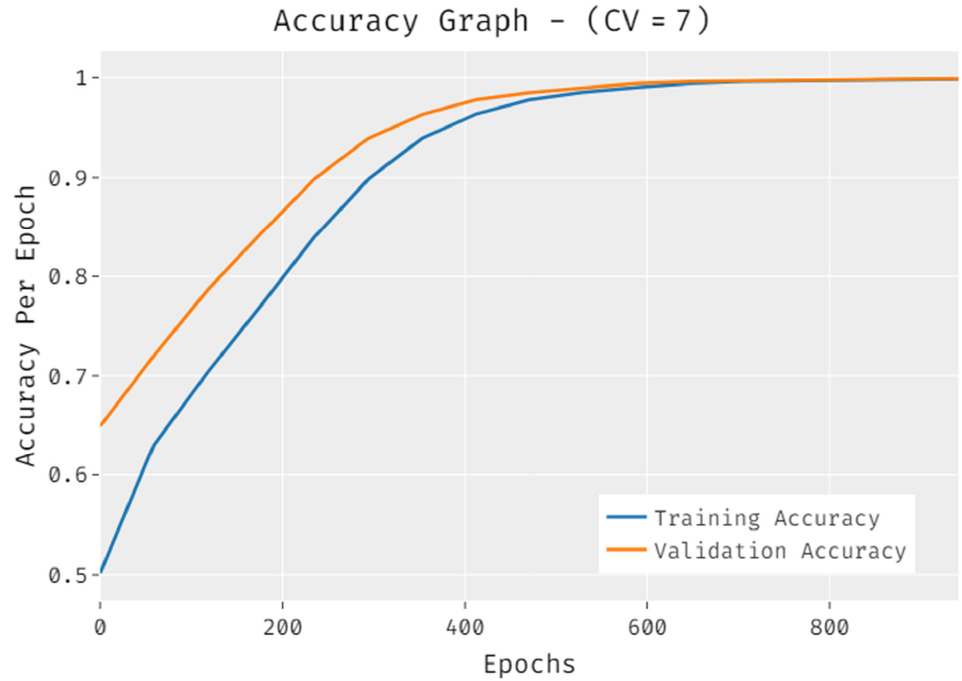
Figure 7. Accuracy analysis of IDLDMS-PTC technique under CV of 7.